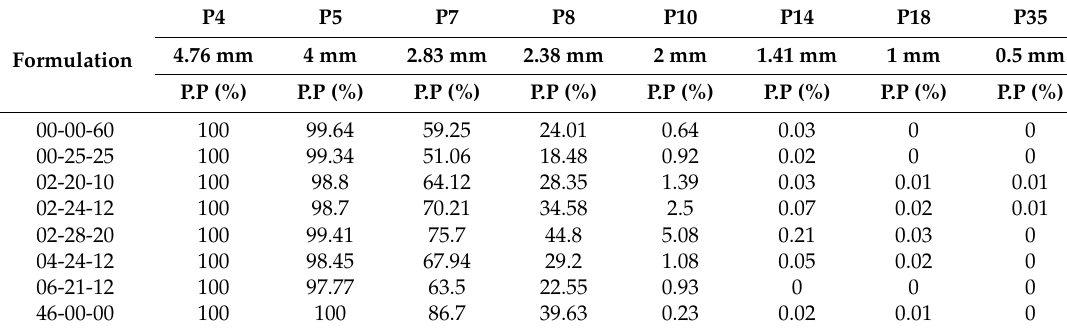
Table 2. Granulometric analysis results.